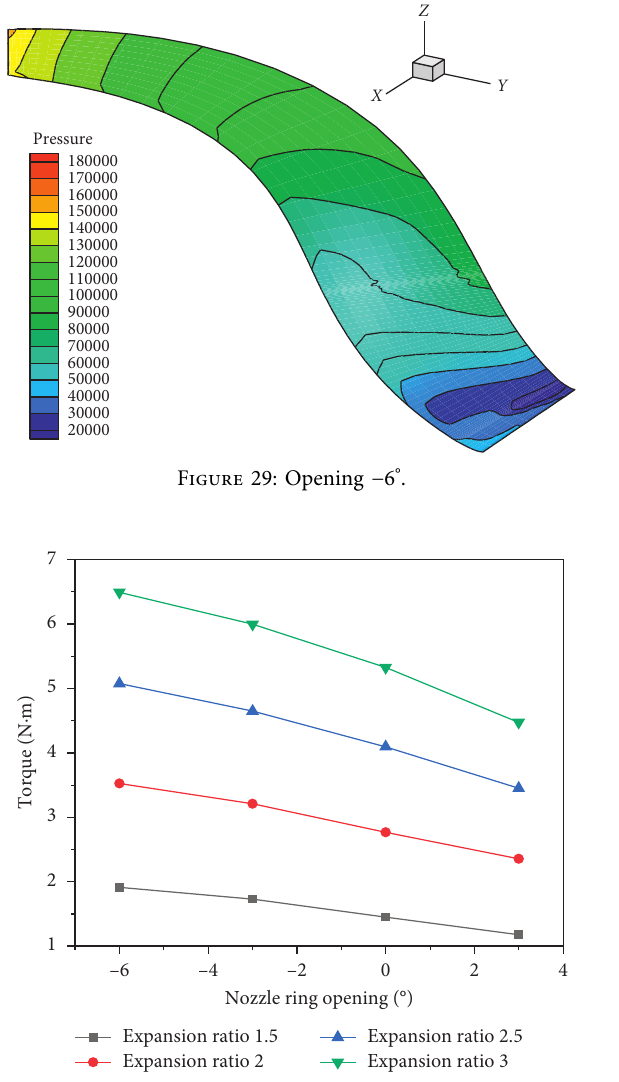
Figure 30: Relationship between opening and